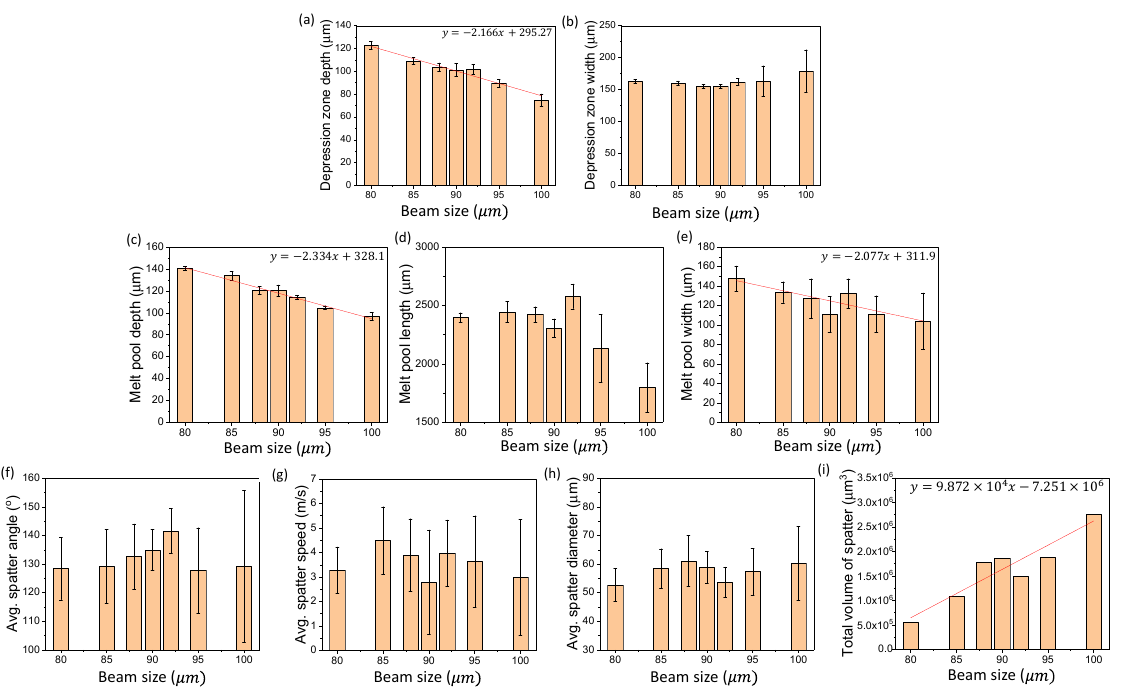
Figure 5. Effects of laser beam size variation on SLM dynamics. ( a , b ) Changes in the depression zone depth and width due to variation in the laser beam size. ( c – e ) Changes of the melt pool depth, length, and width due to variations in laser beam size. ( f – i ) Changes of the spatter average direction, speed, diameter, and total volume due to variation in the laser beam size. All testing is conducted using 15–25 µm, plasma atomized Ti6Al4V powder.